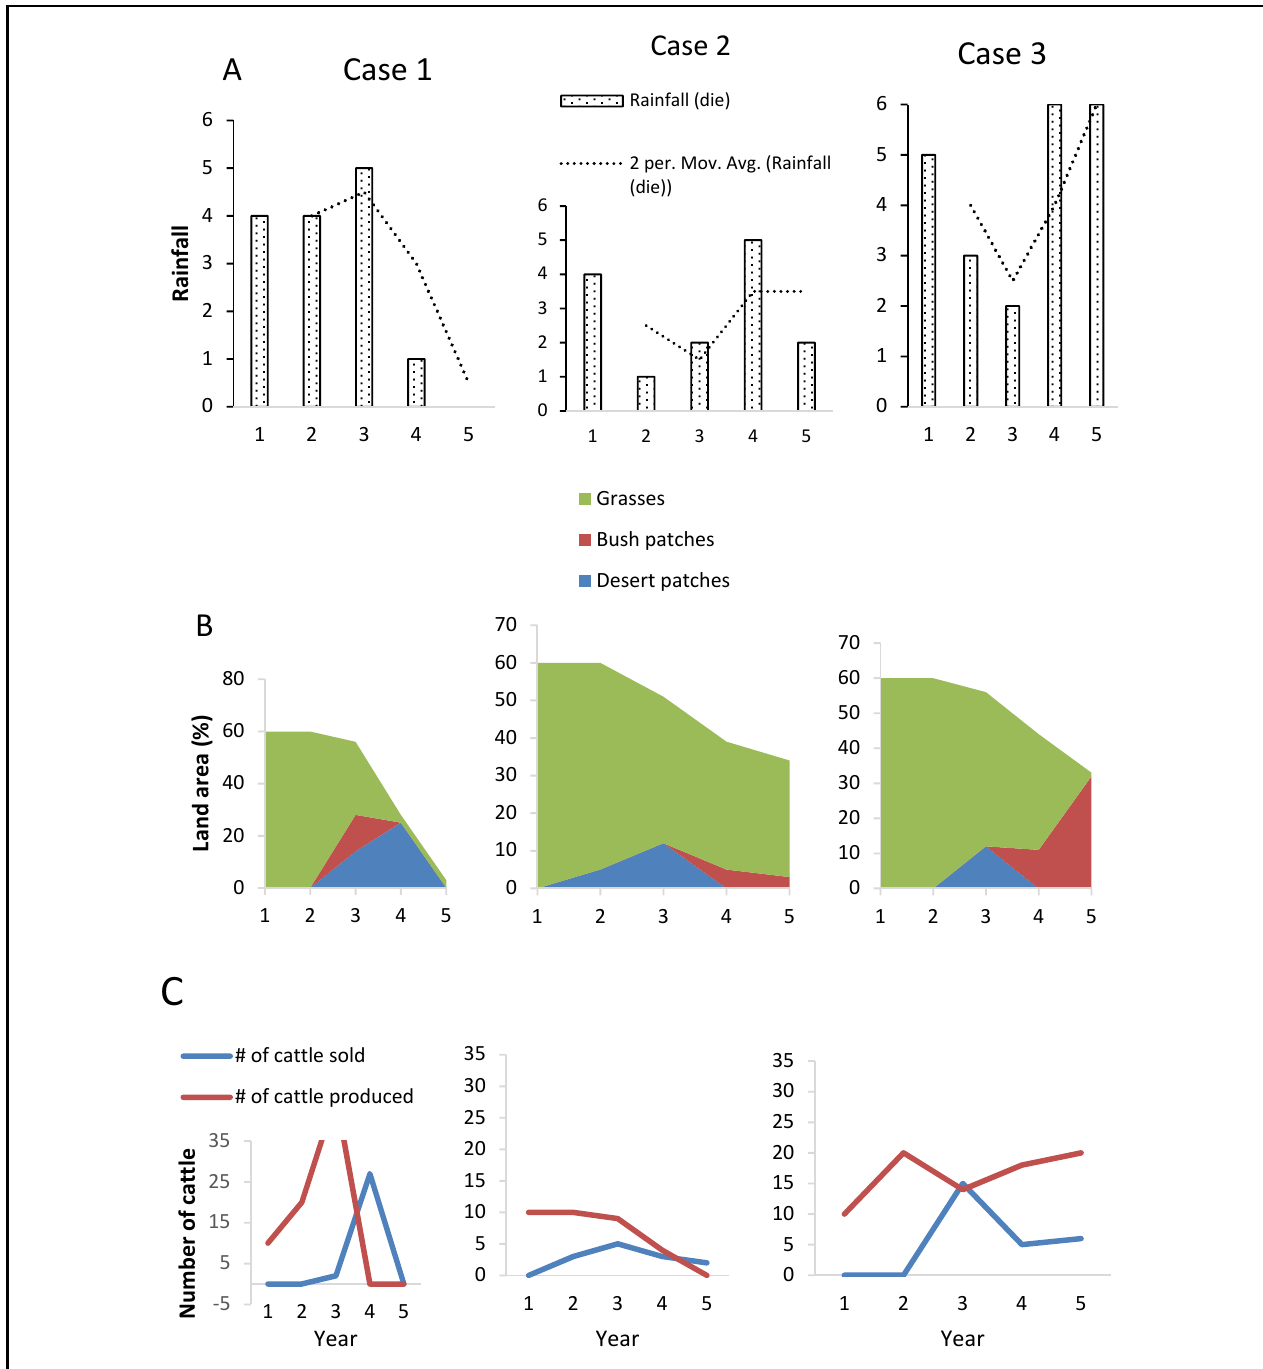
Figure 10. Results of female grazing game depicting rainfall patterns under dry conditions with decreasing rainfall (Case 1), dry conditions with ascending rainfall (Case 2), and wet conditions with ascending rainfall (Case 3): ( A ) pattern of average rainfall, ( B ) land use patterns, and ( C ) cattleproduction trends (n female games = 22; n male games = 22).